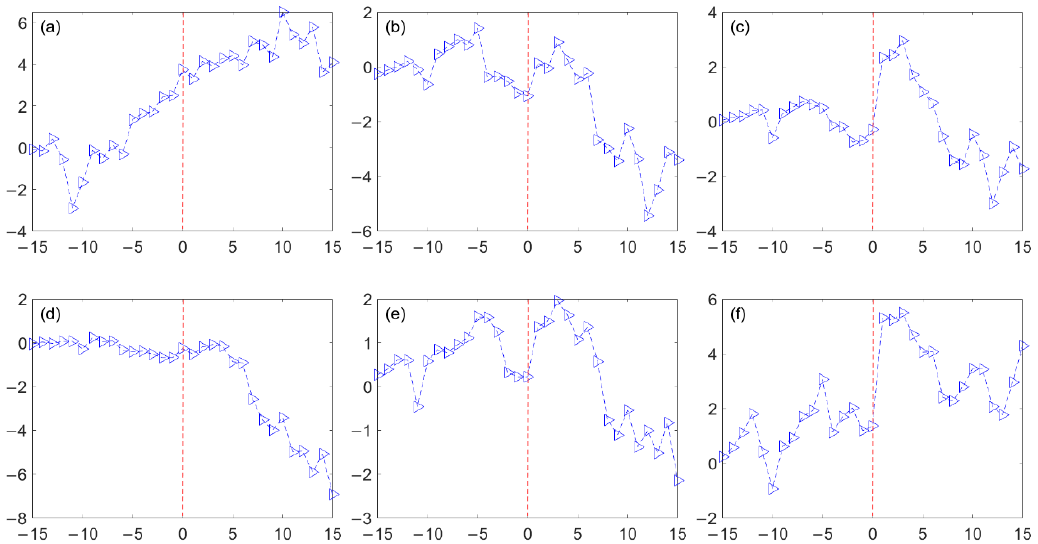
Figure 9. Strike of the COVID-19 outbreak on the outlier of net spillover effect: ( a – f ) show the outlier of net spillover between the carbon market (CT) and oil (OPI), electricity (PI), steel (SI), chemicals (CI), non-ferrous metals (NFMI), and banking (BI) sectors, respectively.